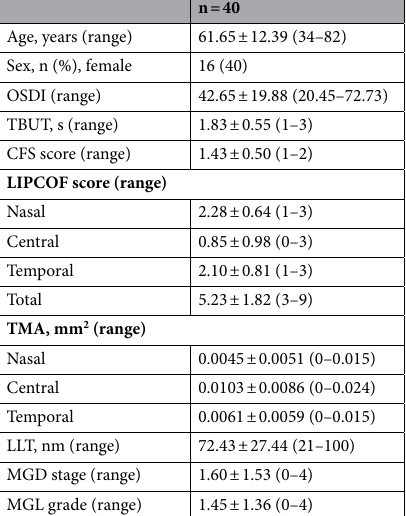
n = 40 61.65 ± 12.39